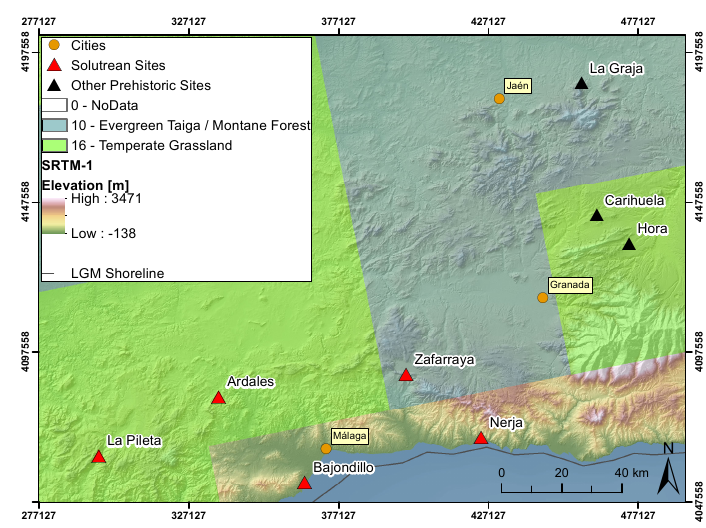
Figure 1. Overview of the prehistoric sites that were used for the evaluation of the DEMs and Stage3 21 ka biome classes [73].